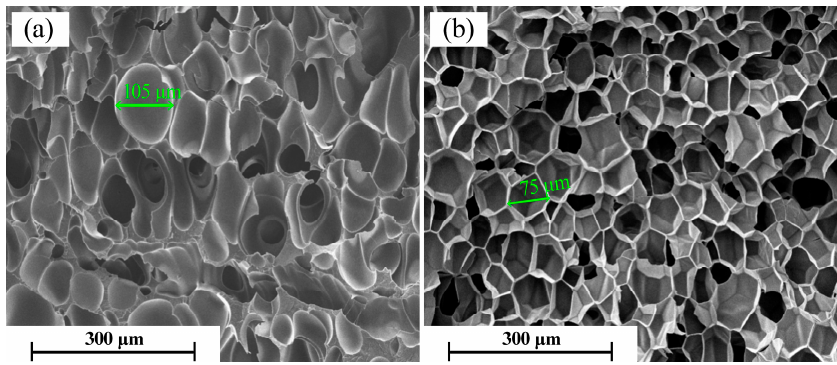
Figure 9. SEM micrographs for two foaming specimens of foamed PP, prepared at 152 °C and 20 MPa: ( a ) non-cross-linked and ( b ) cross-linked (30 kGy).